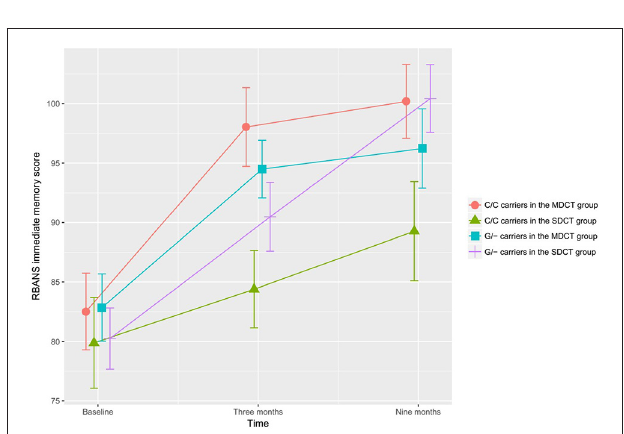
FIGURE 3 | The effects of catechol-O-methyltransferase (COMT) polymorphism on immediate memory. COMT polymorphism determined training benefits in the SDCT group only, indicating a larger gain for G/- carriers than C/C carriers, F ( 2,104 ) = 4.990, p = 0.023, false discovery rate (FDR) corrected. Training benefits differed between MDCT and SDCT in both G/- carriers, F ( 2,118 ) = 4.624, p = 0.023, FDR corrected, and C/C carriers, F ( 2,70 ) = 4.345, p = 0.023, FDR corrected. Note: MDCT, multi-domain cognitive training; SDCT, single-domain cognitive training; RBANS, Repeatable Battery for the Assessment of Neuropsychological Status, respectively. The error bars represent standard